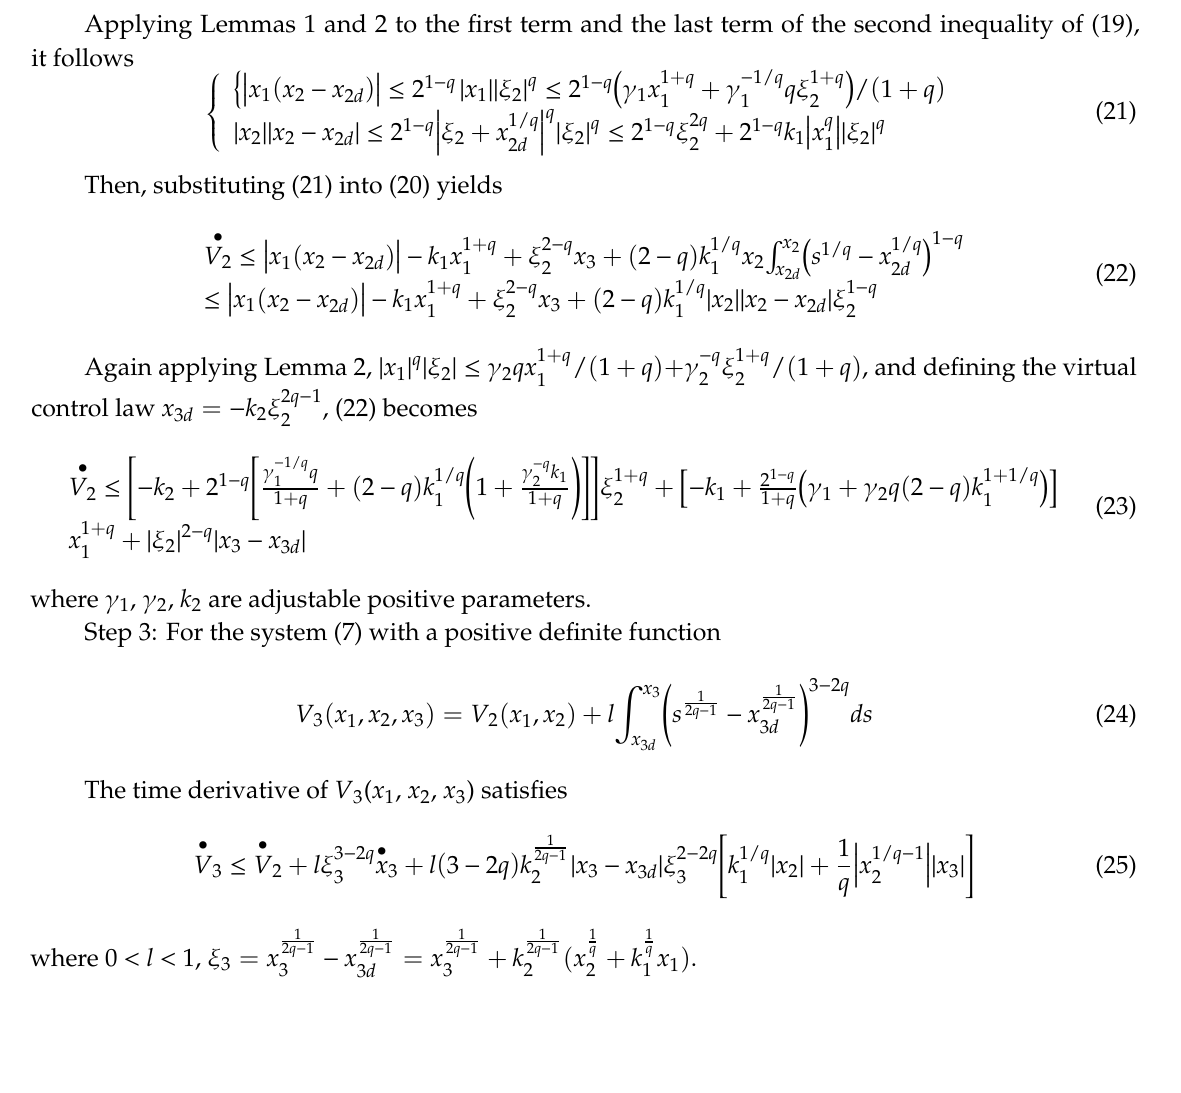
Figure 4. Flowchart of the improved genetic algorithm.